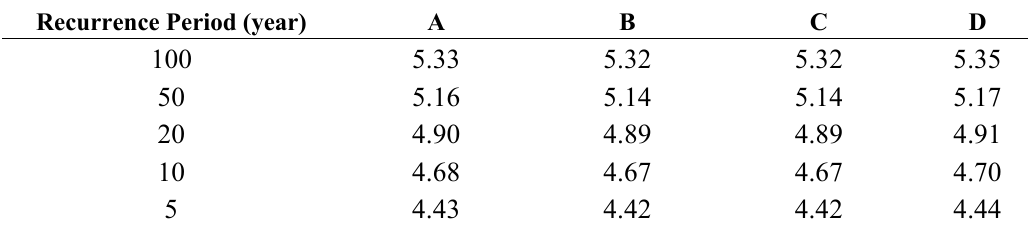
Table 4. Water levels of four main nodes in Figure 7 in meters.